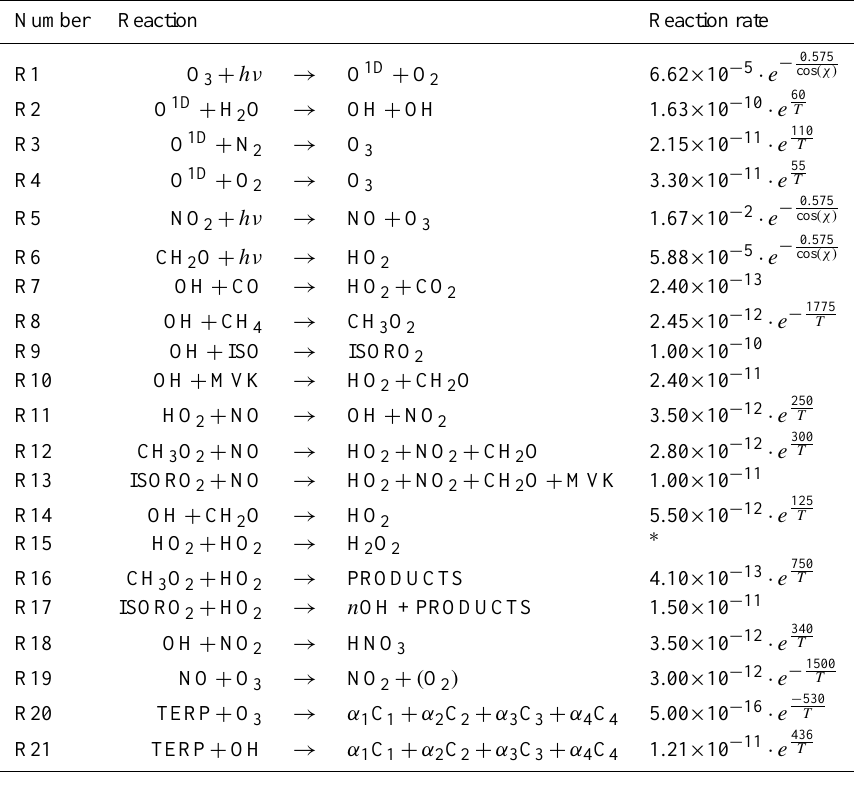
Table 1. Chemical reaction scheme used in the numerical experiments of MXLCH-SOA. In the reaction rate functions, T is the absolute temperature and χ is the solar zenith angle. First-order reaction rates are in s − 1 and second-order reactions are in cm 3 molec − 1 s − 1 . PROD- UCTS are reaction products which are not further evaluated in the chemical reaction scheme. In Reaction (R17), n = 0 (no OH-recycling). α 1 − α 4 are stoichiometric coefficients, see Table 2.